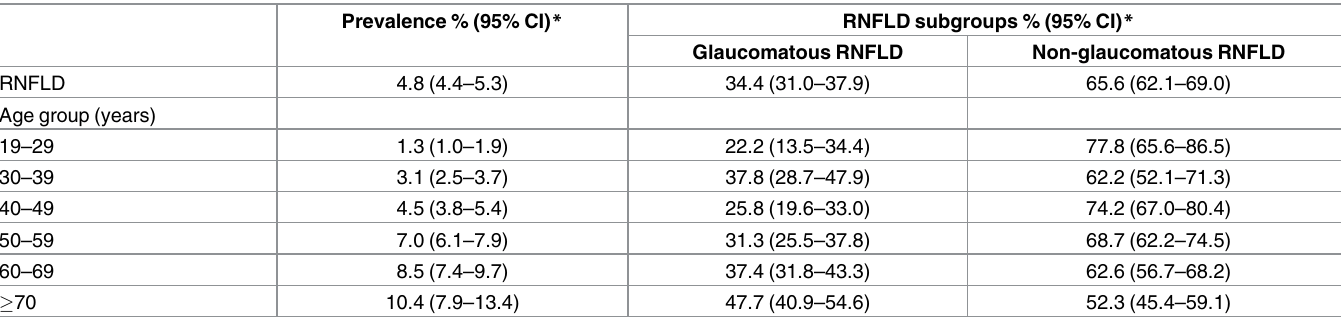
Table 1. Estimated prevalenceof retinal nerve fiber layer